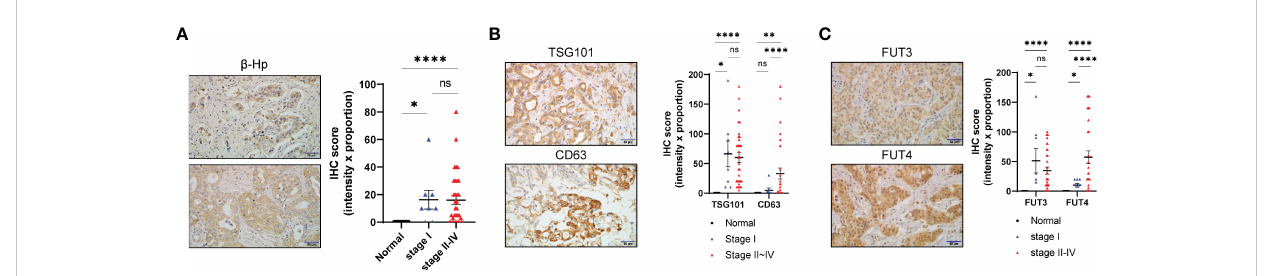
FIGURE 5 Fucosylation of EV-Hp is upregulated by CCA. (A) IHC staining of b -Hp in CCA tissue. Scale bar = 50 m m. IHC scores are shown. (B) IHC staining of TSG101 and CD63 in CCA tissue. Scale bar = 50 m m. IHC scores are shown. (C) IHC staining of FUT3 and FUT4 in CCA tissue. Scale bar = 50 m m. IHC score is shown. Quantitative data are shown as mean ± S.E.M. Statistical analysis was performed using the Mann-Whitney u-test. ****p < 0.0001, **p < 0.01, *p < 0.05, ns p > 0.05. ns, not signi fi cant.